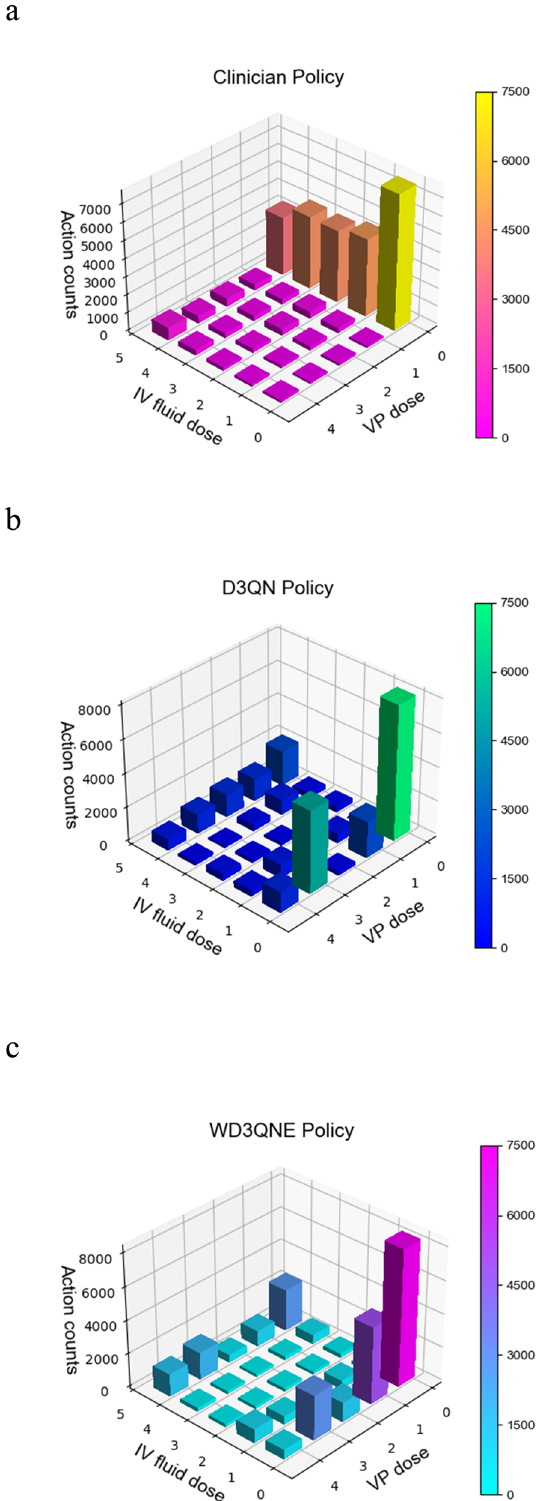
Fig. 3 Action distribution for the test set. a Action distribution of the human clinician policy. b Action distribution of the DQ3N policy with 37 observation features. c Action distribution of the WD3QNE policy with 37 observation features. We aggregate all actions selected over all timesteps for the fi ve dose bins of both medications. 0 denotes no drug given. We discretize the action space into per-drug quartiles. Action counts represent the utilized times of the drug dose. We can see that the human clinician policies tend to use low doses of vasopressors. The pure AI clinician policies (D3QN) tend to use high doses of vasopressors. The AI clinician policies with embedded human expertise (WD3QNE) tend to use lower doses of vasopressors than D3QN and higher doses of vasopressors than the clinician.